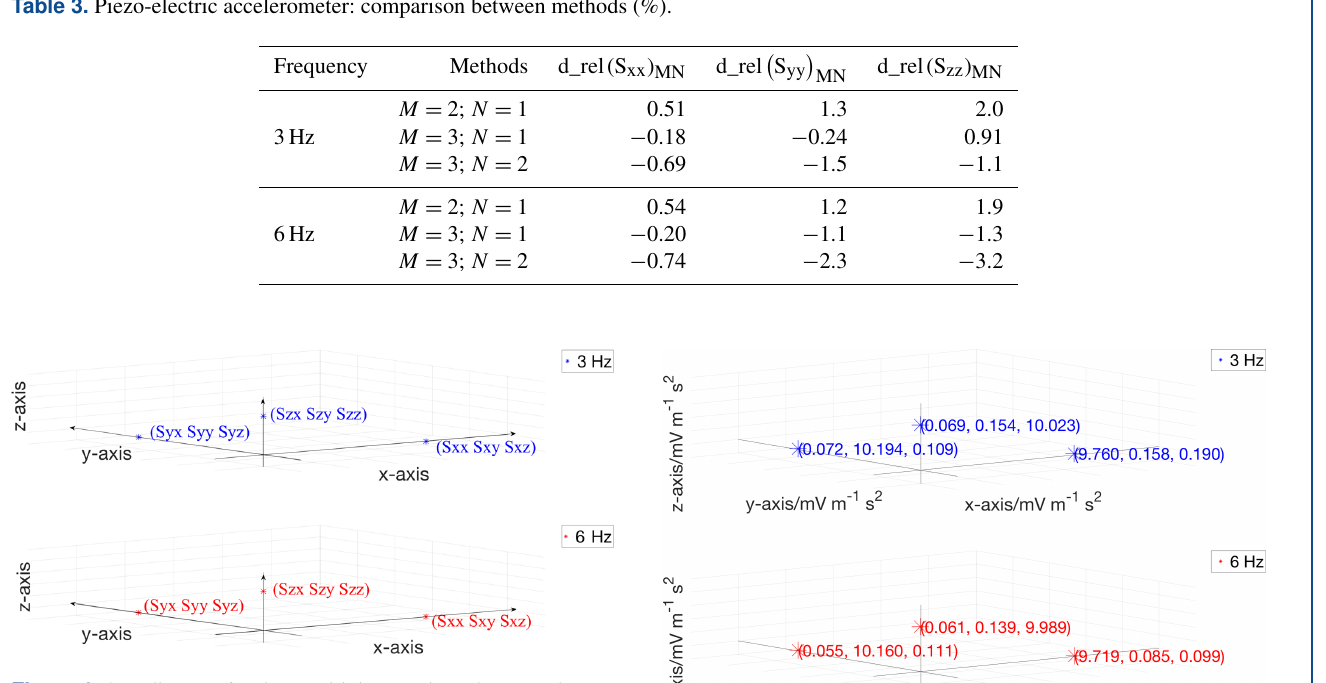
Figure 6. 3-D diagram for the sensitivity matrix: scheme and nota- tion.